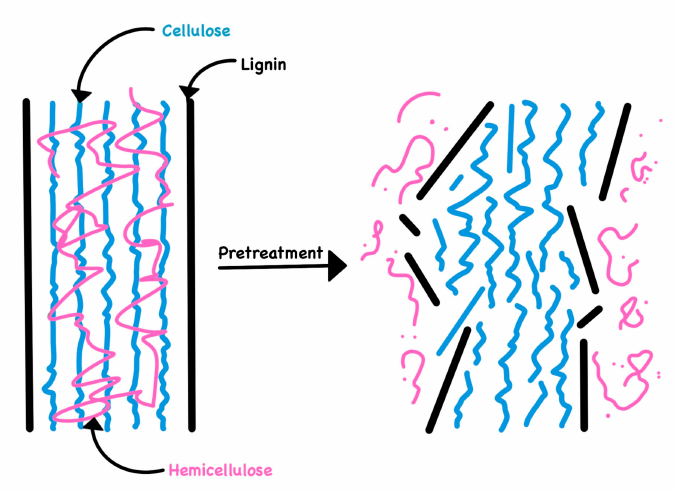
Figure 3. Schematic representation of pretreatment of lignocellulosic substrates (Adapted from Ji et al. [65] and Mosier et al. [66])